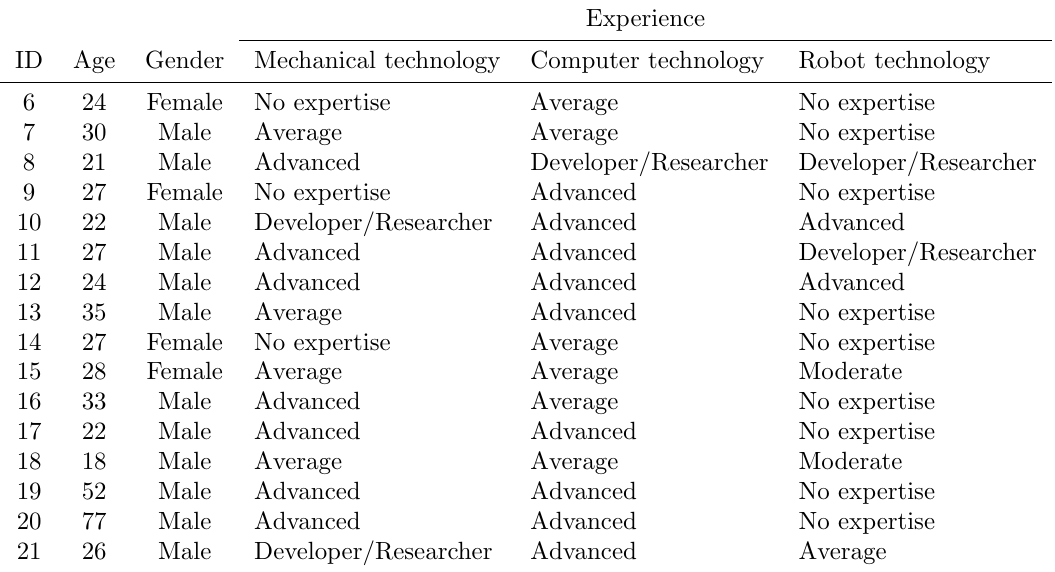
Table 1: Pre-test survey on experince